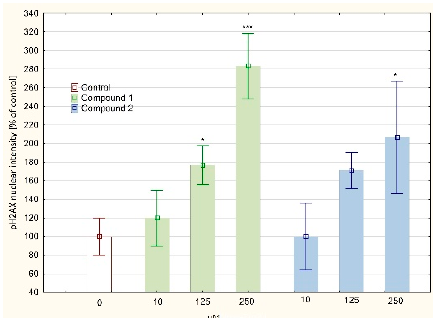
Figure 9. The content of double strands breaks (DSB) in tested cell’s DNA (based on phosphorylated H2AX level) presented as a % of control. The cells were treated with compound 1 or 2 for 24 hours. The DSBs level was measured by specific antibody-based detection of phosphorylated H2AX (Ser139) in the nucleus. The fluorescence of secondary antibody was measured using the SpectraMax i3 Multi-Mode Platform. Values were presented as mean ± SD. * p < 0.05, *** p < 0.001 vs. control; (ANOVA followed by Tukey’s HSD post hoc analysis).